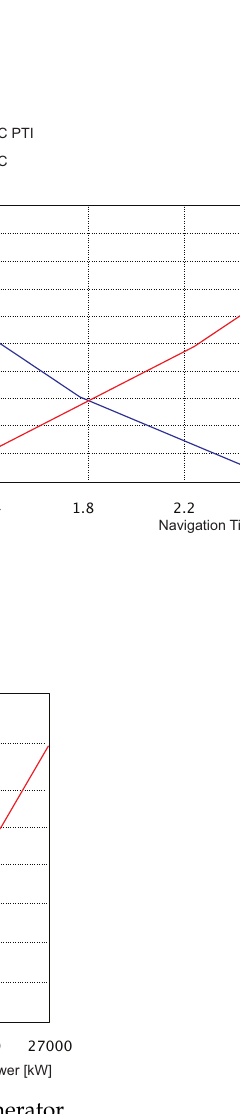
Figure 12. SFC difference at PTI and without shaft generator.